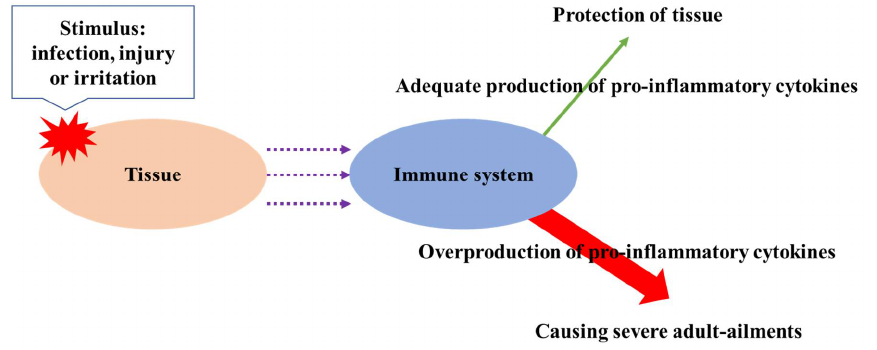
Figure 3. The occurrence of chronical diseases by the overproduction of pro-inflammatory cytokines.